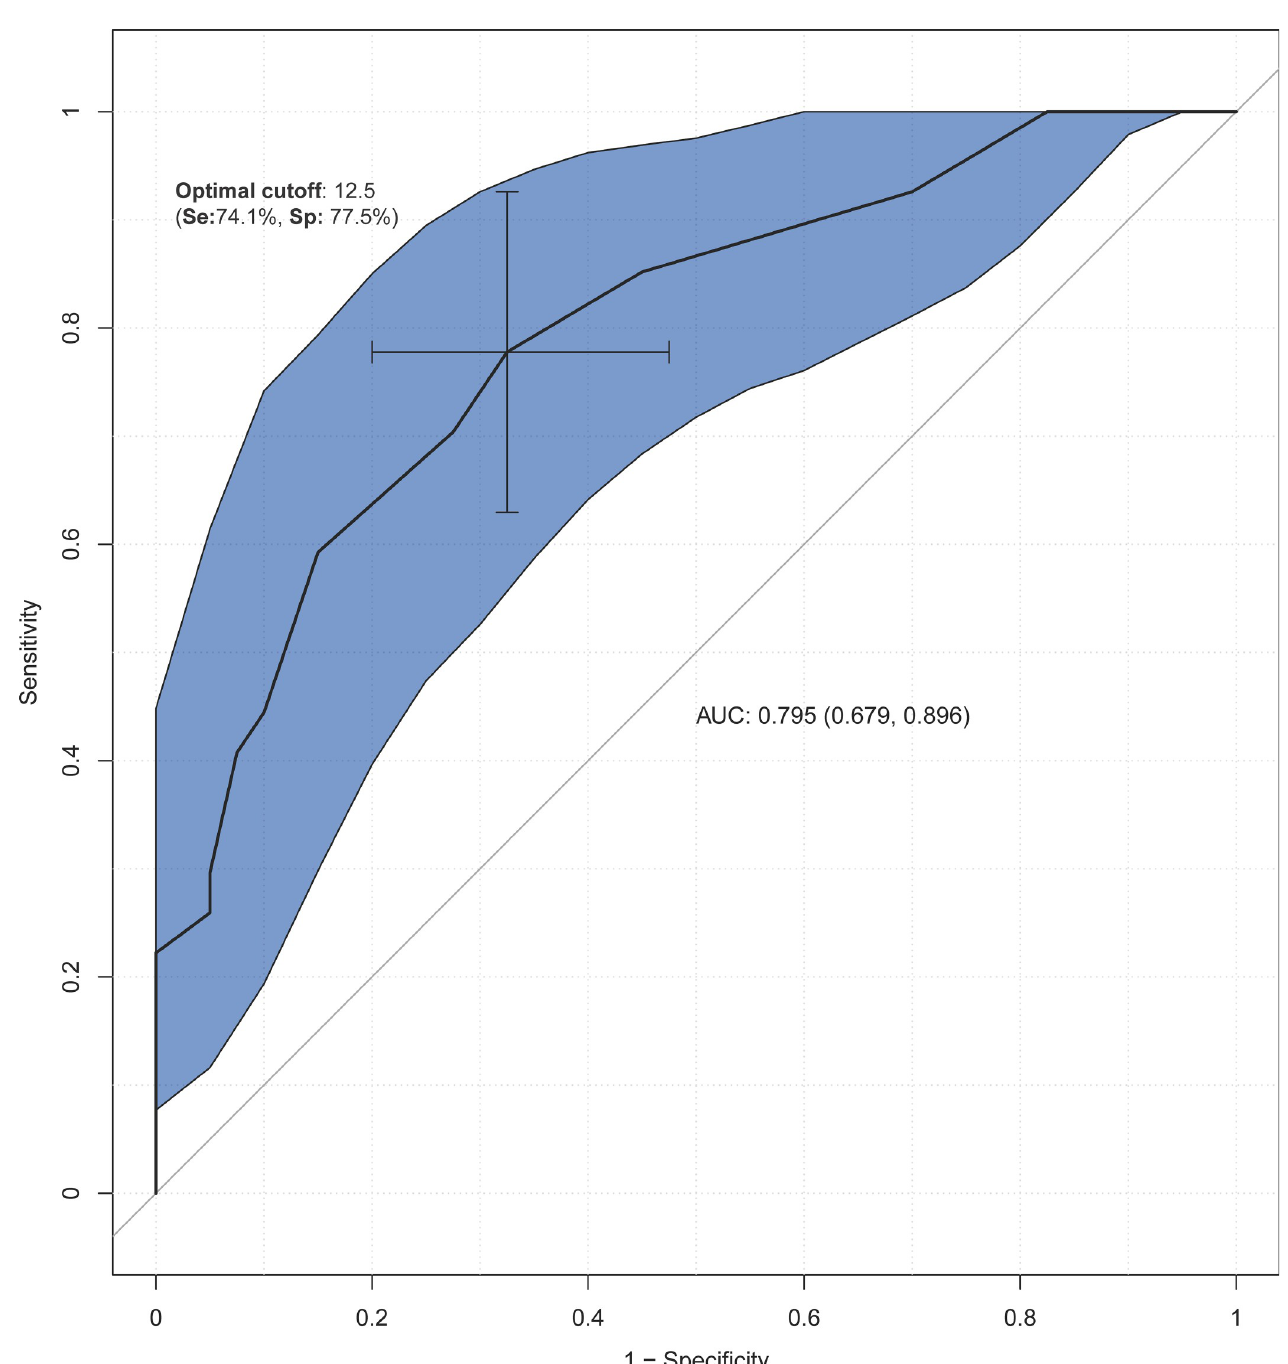
Fig 2. Discriminant power of the FAB-E among Parkinson’s disease patients with (MMSE < 26) and without (MMSE � 26) cognitive impairment. Abbreviations: Se, sensitivity; Sp, specificity; AUC, area under the curve.